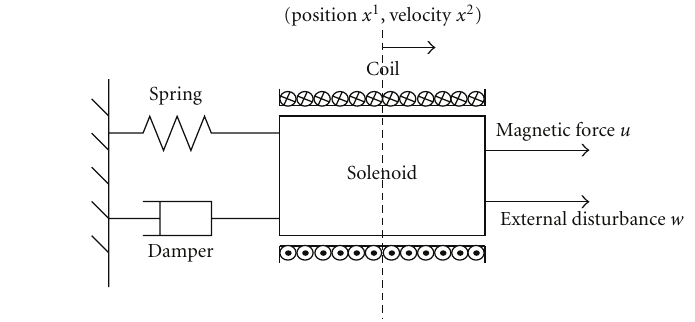
Figure 1: Solenoid system.